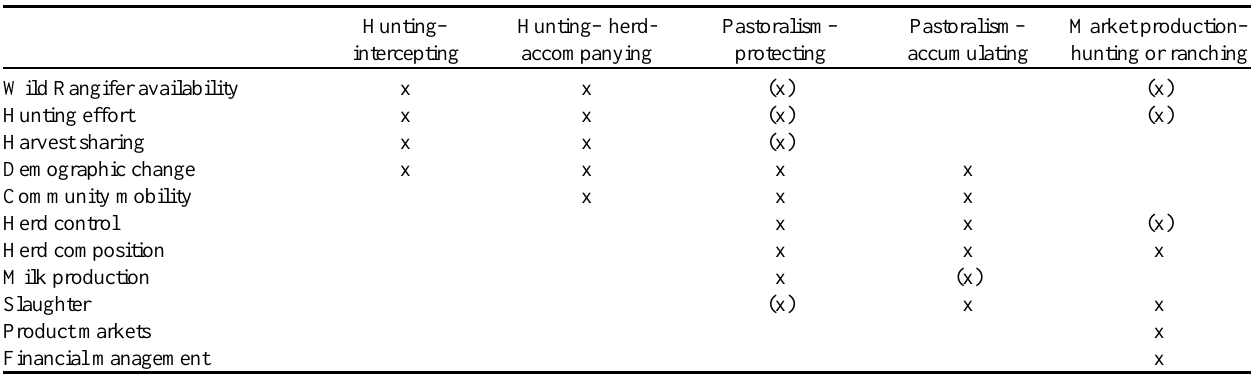
Table 1. Key processes in human–Rangifer systems and presence in different system states. ("x" in a cell indicates a process typically a significant feature of the system; "(x)" in a cell indicates a process locally present but not prominent)